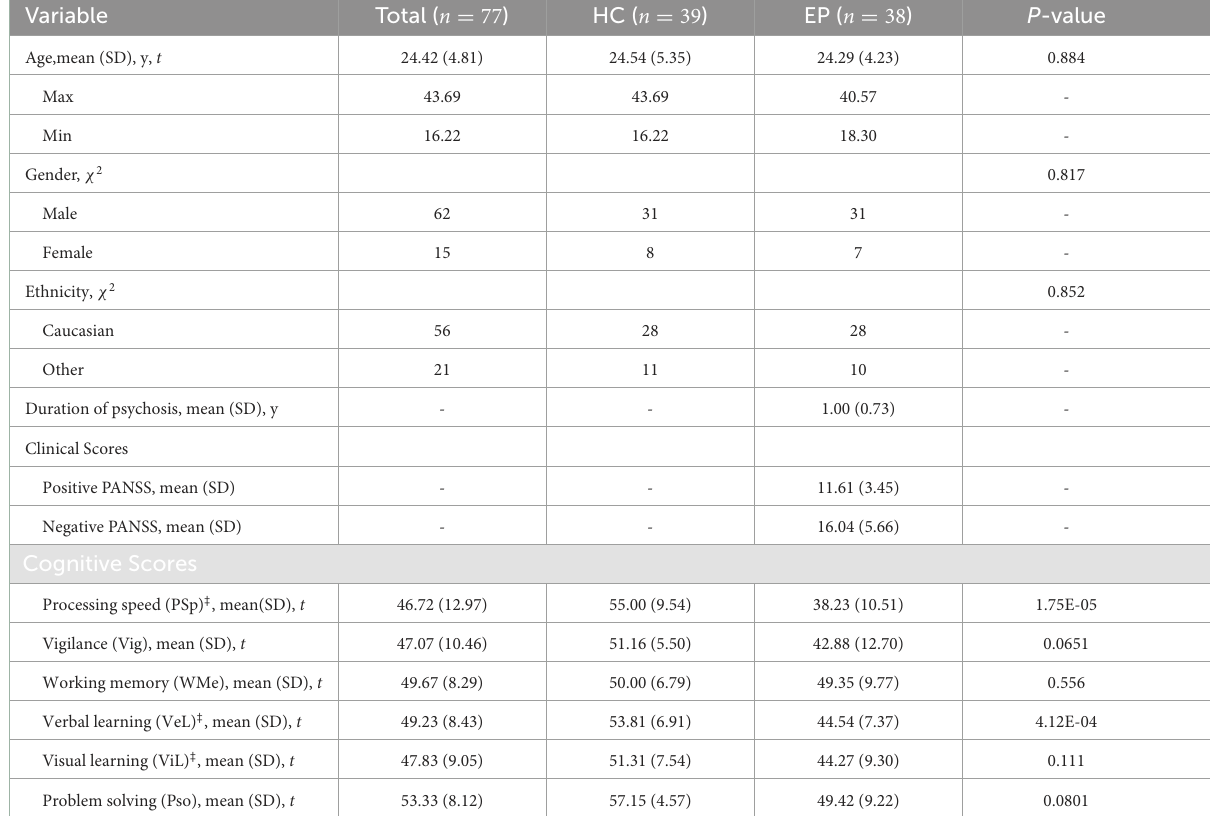
TABLE 1 Demographic information and neurocognition performance of 77 subjects.